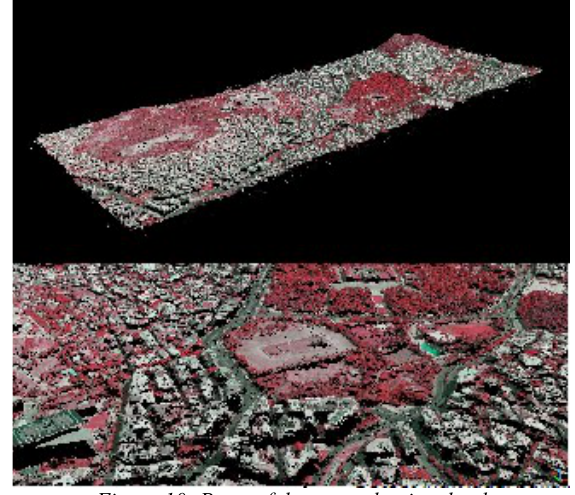
Figure 10: Parts of the created point cloud